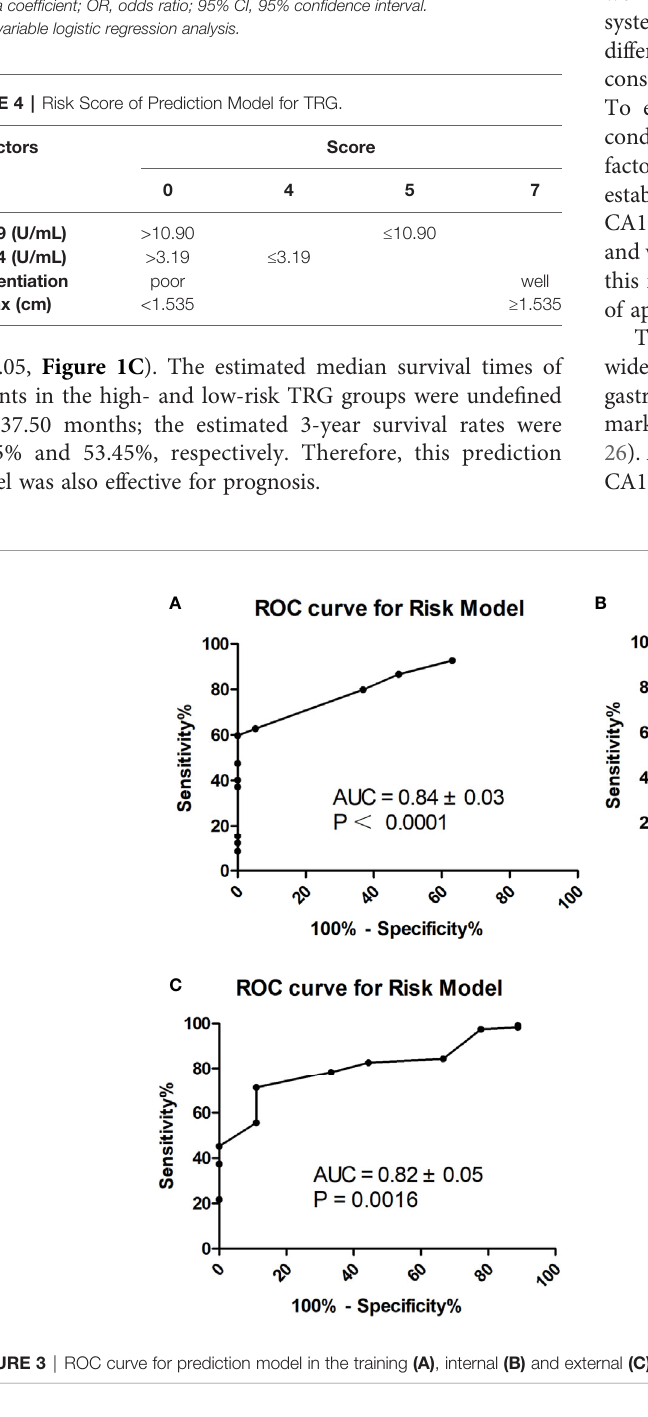
FIGURE 3 | ROC curve for prediction model in the training (A) , internal (B) and external (C) validation